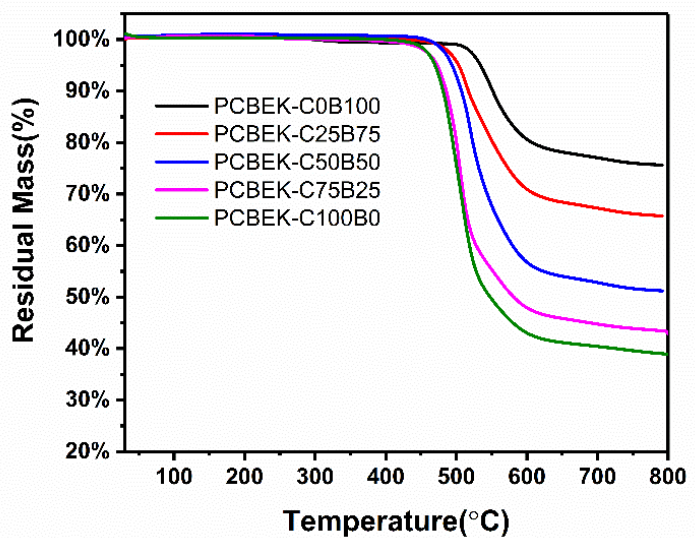
Figure 4. TGA curves of PCBEKs polymers under N 2 atmosphere. Table 2. Thermal performance parameters of copolymer PCBEKs.